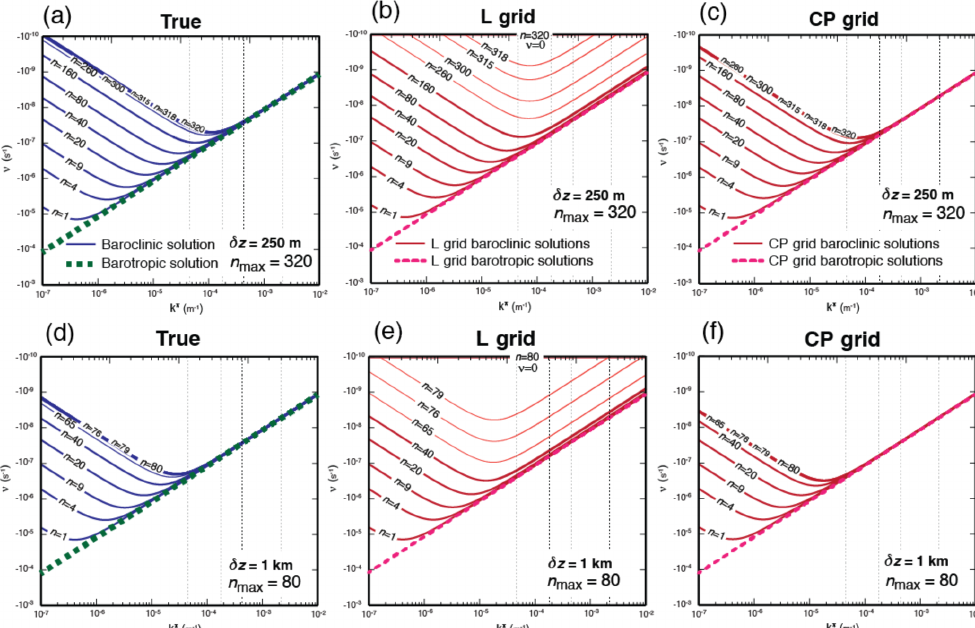
Figure 7. Plots of (a, d) true and discrete frequencies for the baroclinic and barotropic Rossby modes obtained on the (b, e) L and (c, f) CP grids. The thick blue and green dashed lines on the left panels indicate the true baroclinic and barotropic frequencies, respectively. The thick red and red dashed lines on the center and right panels indicate the discrete baroclinic and barotropic frequencies, respectively. The upper and lower panels show the plots for the maximum vertical integer wavenumbers of n max = 320 ( δz = 250m) and n max = 80 ( δz = 1km),